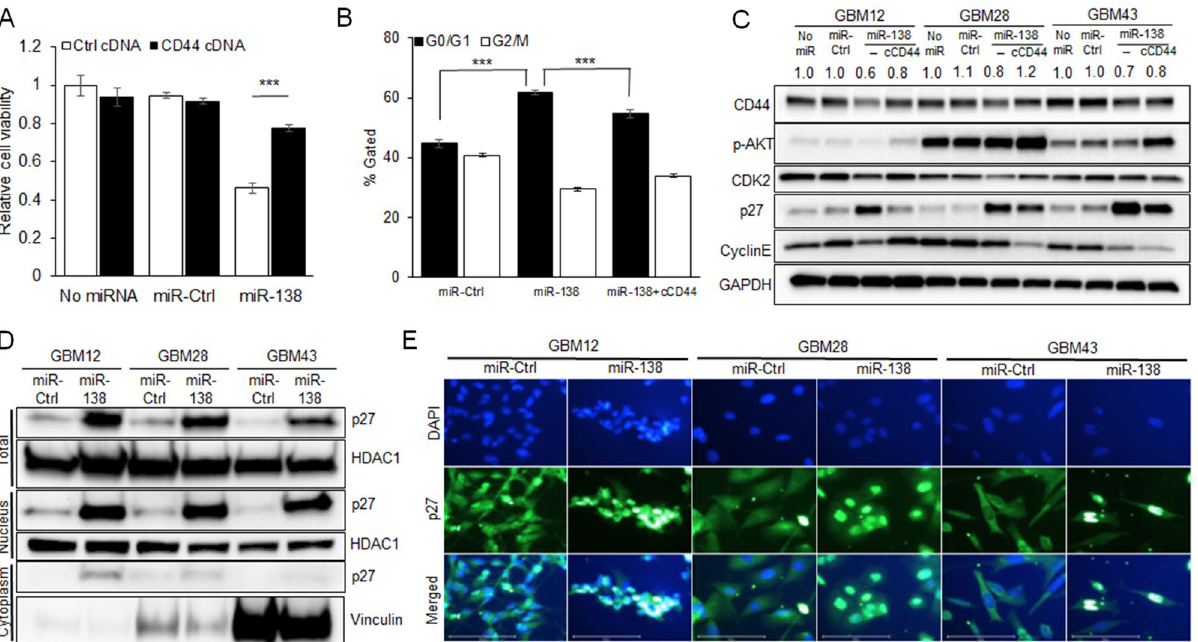
Figure 4. CD44 inhibition by miR-138 induces cell cycle arrest through upregulation of cell cycle inhibitor p27. ( A ) Cell viability of GBM cells decreases by miR-138 overexpression, which is partially rescued by ectopic overexpression of CD44. GBM cells were transfected with miR-138 or miR-Ctrl for 96 days in the presence CD44 expressing cDNA plasmids or empty control vector DNAs. Cell viability was measured by CellTiter-Glo Luminescent Cell Viability Assay (n = 3). ( B ) Cell cycle analysis by flow cytometry on GBM28 cells after 4 days of transient transfection of miR-138 or miR-Ctrl. Comparison of cell populations between G0/G1 and G2/M phases were expressed as %gated cells to total cell populations. Arrested cell cycle at G0/G1 phase by miR-138 was partially reversed by ectopic overexpression of CD44. Cell cycle data from GBM12 and GBM43 cells were shown in Supplementary material Fig. S7. Representative cytograms were shown in Supplementary material Fig. S8. ( C ) CD44 inhibition by miR-138 induces cell cycle arrest through Akt/p27 signaling axis. Transiently transfected GBM cell lysates with miR-138 or miR-Ctrl were analyzed by western blotting. miR-138 mediated CD44/Akt/p27 modulation was partially rescued by ectopic overexpression of CD44. ( D ) Western blotting showing activation and nuclear translocation of p27 in GBM cells after miR-138 overexpression. Total GBM cell lysates harvested after 4 days of transient transfection with miR-138 or miR-Ctrl were separated into nuclear and cytoplasmic fractions and analyzed by western blotting. HDAC1 was used as loading control for total cell and nucleus fractions, while Vinculin was used for cytoplasmic fractions. ( E ) Immunofluorescence staining of GBM cells that were transfected with miR-138 or miR-Ctrl for 4 days. Nuclear translocation of p27 was observed by overlapped fluorescence intensity of FITC-labeled anti-p27 antibody with DAPI staining. Scale bars indicate 100